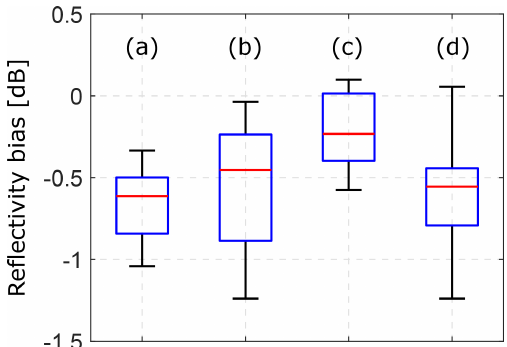
Figure 14. Reflectivity biases, due to the calibration coefficient C Z , estimated using the self-consistency method applied to observa- tions at a 30 ◦ elevation angle during rain events on 9 June 2018 at 21:00UTC (a) , 20 July 2018 at 17:00UTC (b) , and 28 July 2018 at 11:22UTC (c) . The box plot (d) shows the results for all 64 avail- able samples. The measurements were taken with radar 1 at the RPG site. The total number of samples are 45 for (a) , 11 for (b) , and 8 for (c) . The upper and lower edges of the boxes correspond to the 75th and 25th percentiles, respectively. The upper and lower whiskers in- dicate the 95th and 5th percentiles, respectively. The horizontal red bars correspond to the median values.